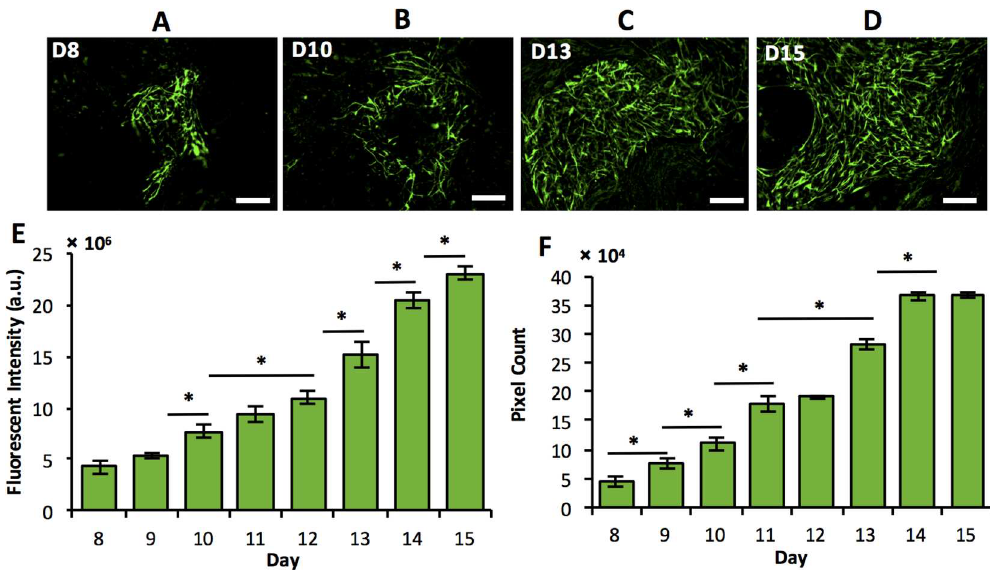
Fig 7. Immunocytochemical analysesof GFAP stained images. (A-D) GFAP-positive astrocyte cells derived from co-culturing of mESCs and PA6 cells. (E) GFAP expressionquantifiedusing fluorescent intensity measurements shows a continuous increasein the protein content. (F) Adaptive thresholding of GFAP-stained samples. Scale bar: 100 μ m. * indicates p <